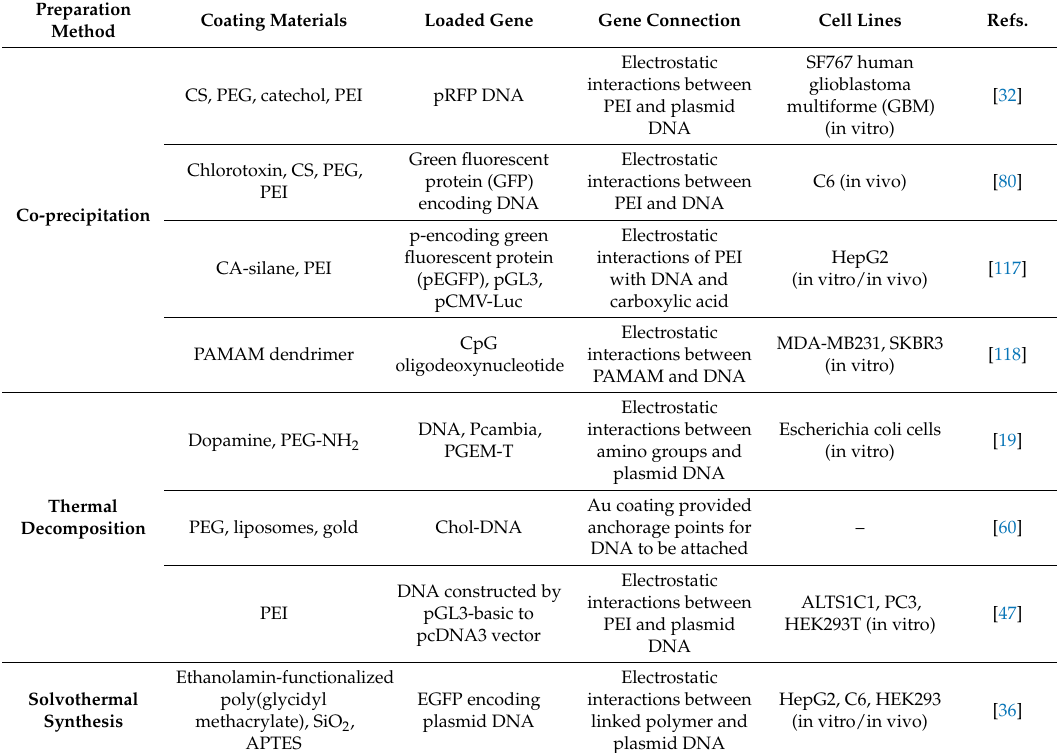
Table 2. Functionalization of Fe 3 O 4 NPs with different coatings for targeted gene